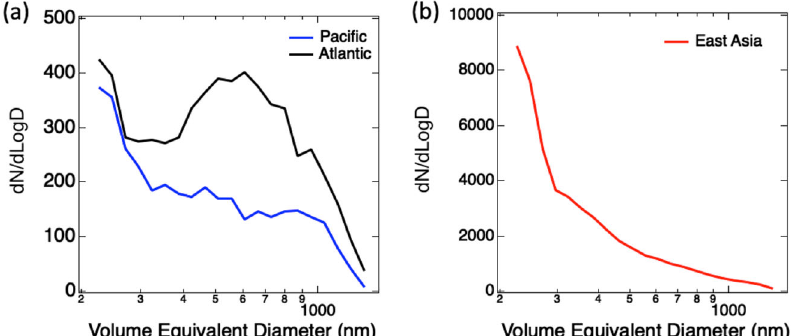
Fig. 5 Size distributions for LAM aerosols observed over Atlantic and Paci fi c and East Asia. The dN/dLogD size distributions for aerosols observed over the remote Paci fi c and remote Atlantic ( a ) and in East Asia ( b ) are shown as a function of the aerosols ’ volume equivalent diameter, assuming LAM aerosols have a void-free density of 5.17 g cm − 3 . The SP2 ’ s detection range falls off below 250 nm and above 1000 nm. We exclude aerosols identi fi ed as artifacts.